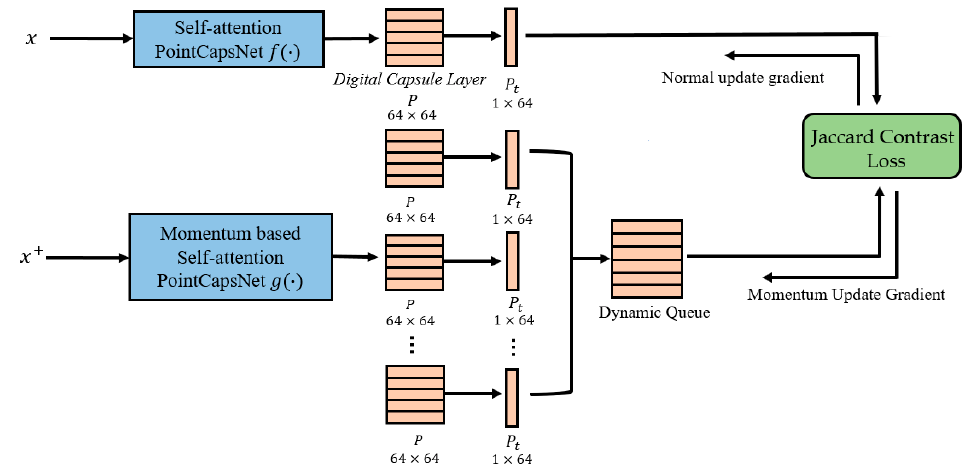
Figure 1. Contrastive learning framework.